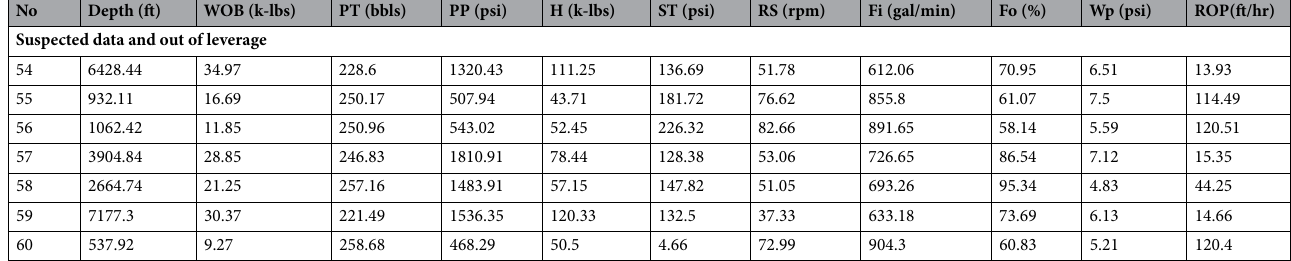
Table 5. Inputs and output which are out of the applicability domain of the DT-GB model based on the leverage